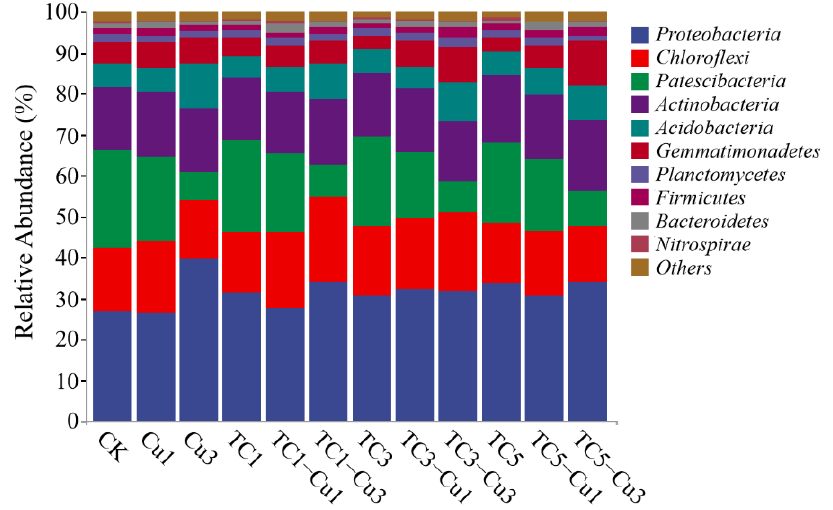
Figure 4. Relative abundance of soil bacterial communities at the phylum level under TC and Cu contamination.